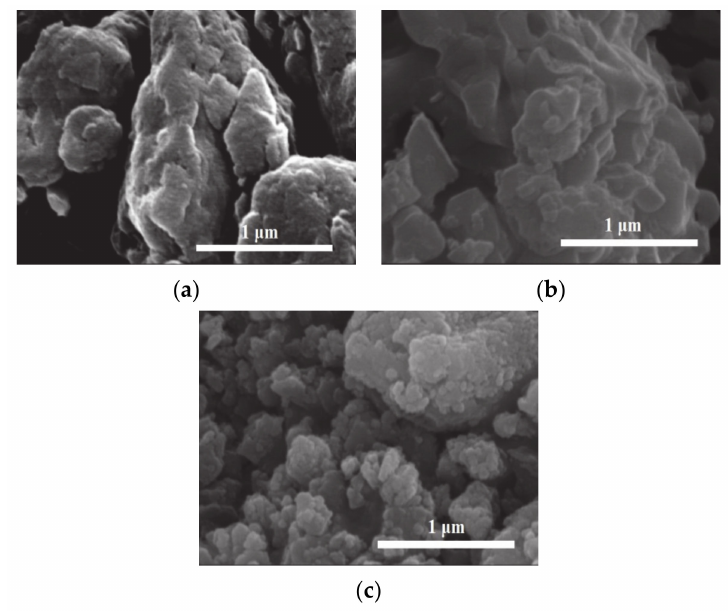
Figure 2. SEM images ( a ) g-C3N4 ( b ) SrAl2O4:Eu,Dy and ( c ) SrAl2O4:Eu,Dy / 15 wt.% g-C3N4.